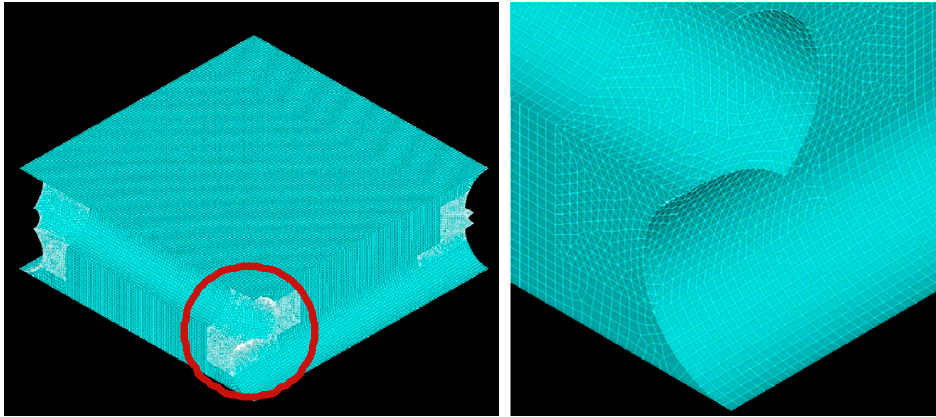
Membranes 2019 , 9 , x FOR PEER REVIEW Figure 3. Computational domain (unit cell): ( a ) θ = 30 ◦ ; ( b ) θ = 60 ◦ ; ( c ) θ = 90 ◦ . Figure 3. Computational domain (unit cell): ( a ) θ = 30°; ( b ) θ = 60°; ( c ) θ = 90°.